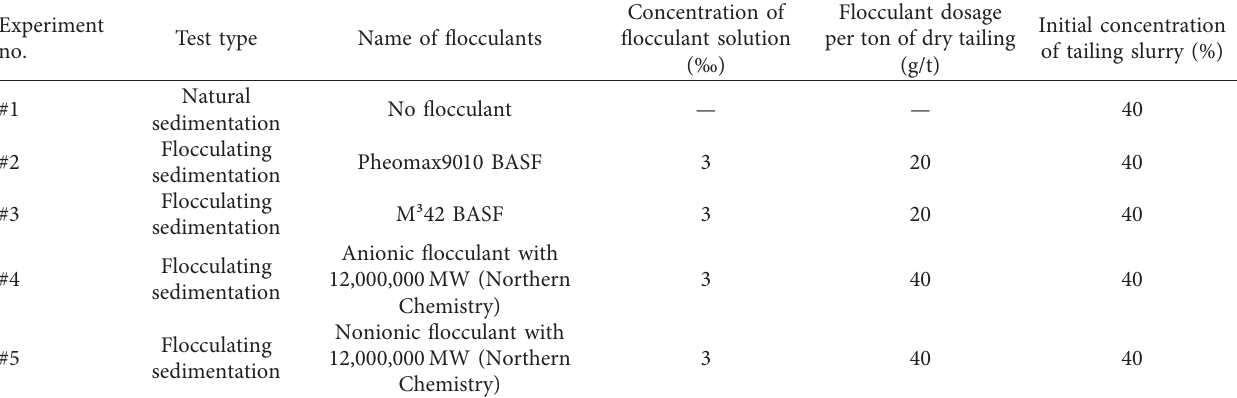
Table 2: Natural and flocculating sedimentation experiments of tailings.